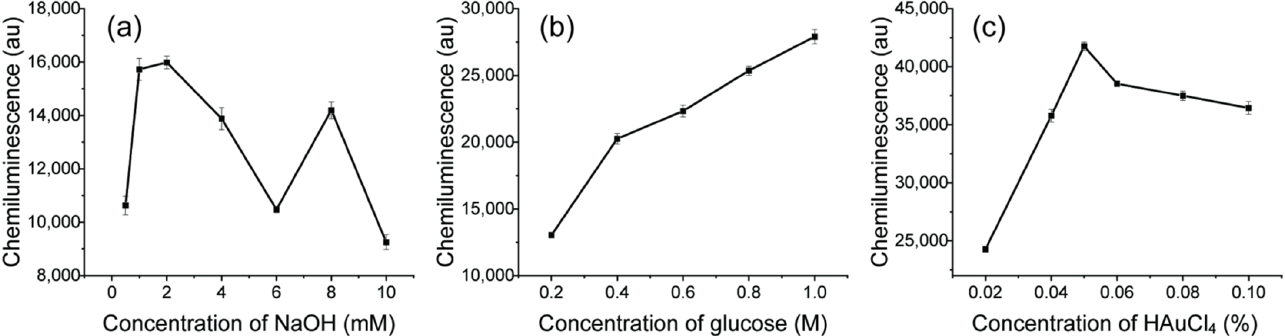
Figure 5. Effects of synthesis conditions on the CL intensity: ( a ) 0.01% HAuCl 4, 0.3 M glucose and different concentrations of NaOH, 0.5, 1, 2, 4, 6, 8, 10 mM; ( b ) 0.01% HAuCl 4, 2 mM NaOH and different concentrations of glucose, 0.2, 0.4, 0.6, 0.8, 1.0 M; ( c ) 2 mM NaOH , 1 M glucose and different concentrations of HAuCl 4, 0.02%, 0.04%, 0.05%, 0.06%, 0.08%, 0.1%.